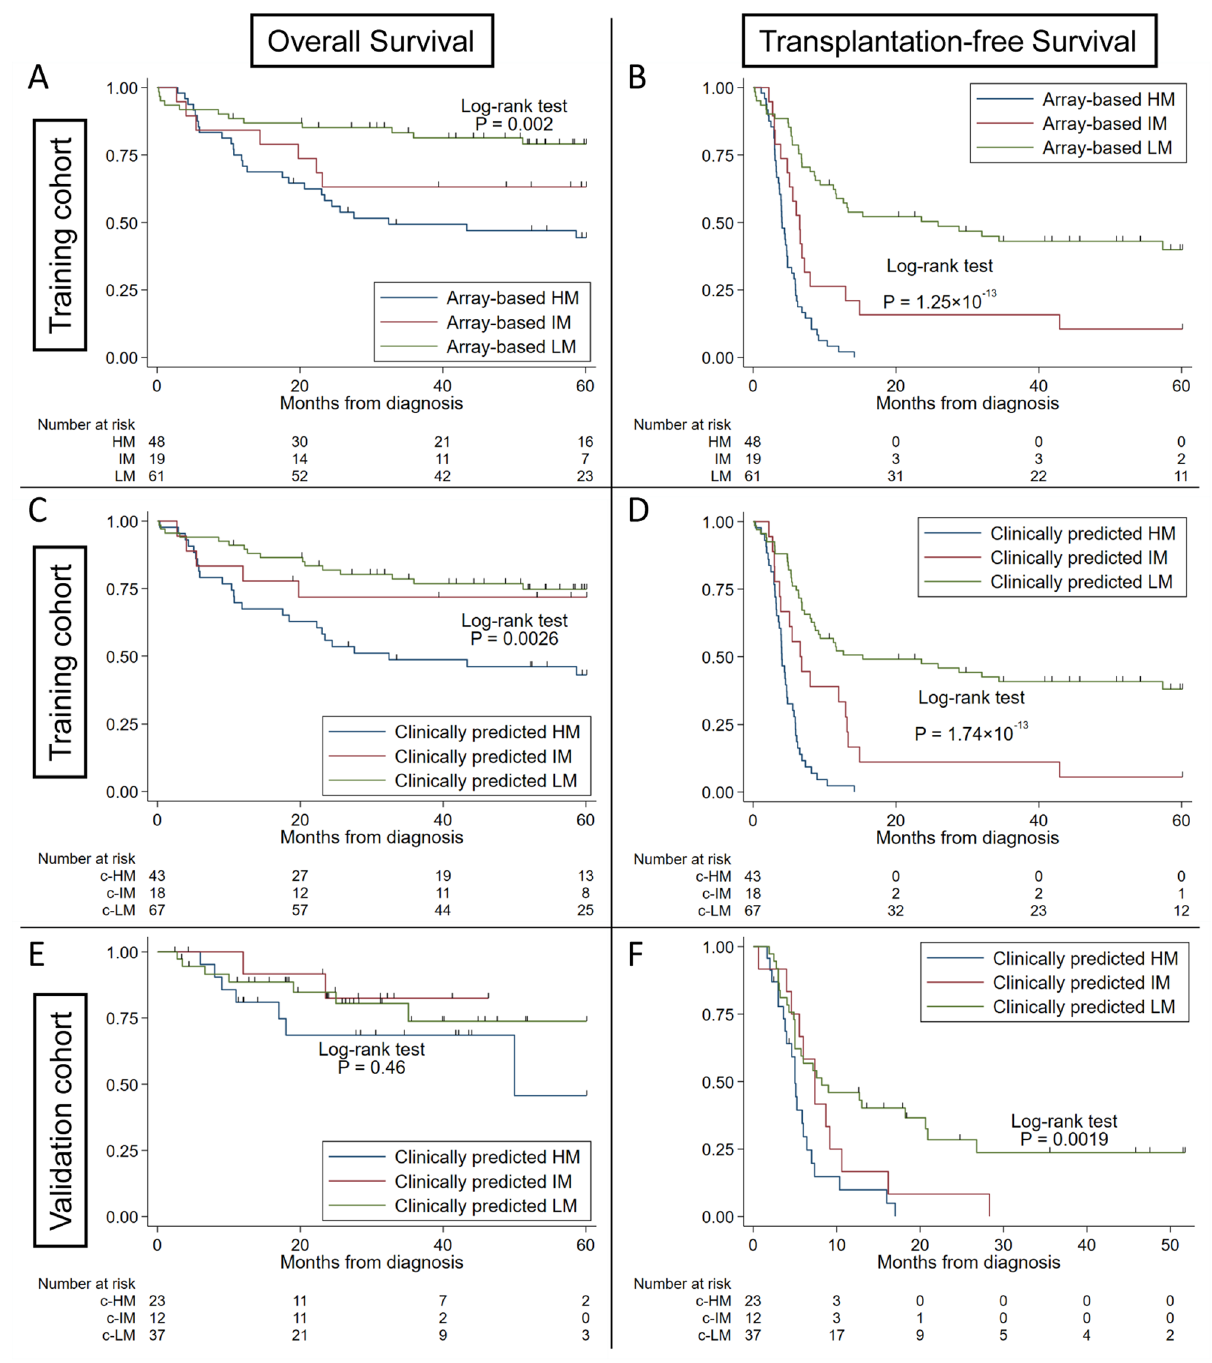
Figure 4. Overall survival and transplantation-free survival based on trichotomized DNA methylation subgroups (HM, IM, and LM). ( A ) Overall survival (OS) by array-based DNA methylation classification in the training cohort. ( B ) Transplantation-free survival (TFS) by array-based DNA methylation classification in the training cohort. ( C ) OS by clinically predicted methylation classification in the training cohort. ( D ) TFS by clinically predicted methylation classification in the training cohort. ( E ) OS in the validation cohort. ( F ) TFS in the validation cohort. Survival curves were estimated using the Kaplan–Meier method, and statistical tests were performed using the log-rank test. Array-based subgroups were significantly different in both OS and TFS in the training cohort (P = 0.002 and 1.25 × 10 −13 ). Clinically predicted HM/IM or LM was significantly associated with both OS and TFS in the training cohort (P = 0.0026 and 1.74 × 10 −13 , respectively) and with TFS in the validation cohort (P = 0.0019). OS overall survival, TFS transplantation-free